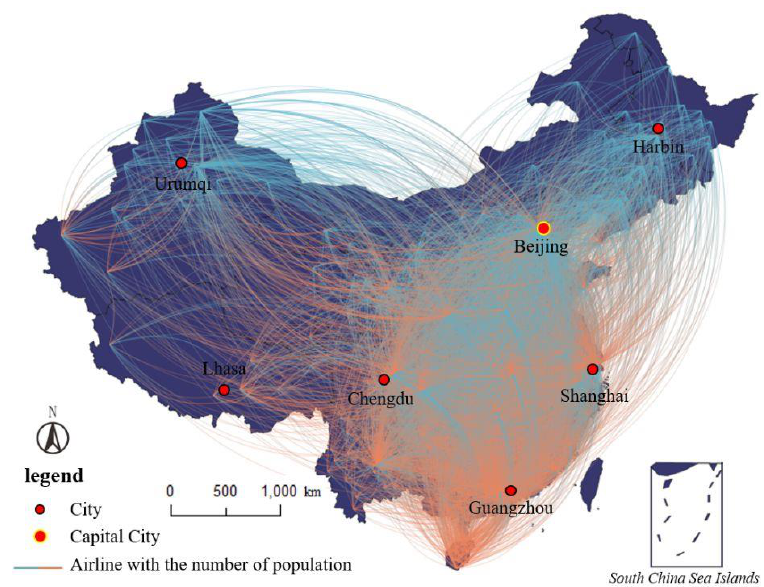
Figure 9. Study area and visualization of flow data.